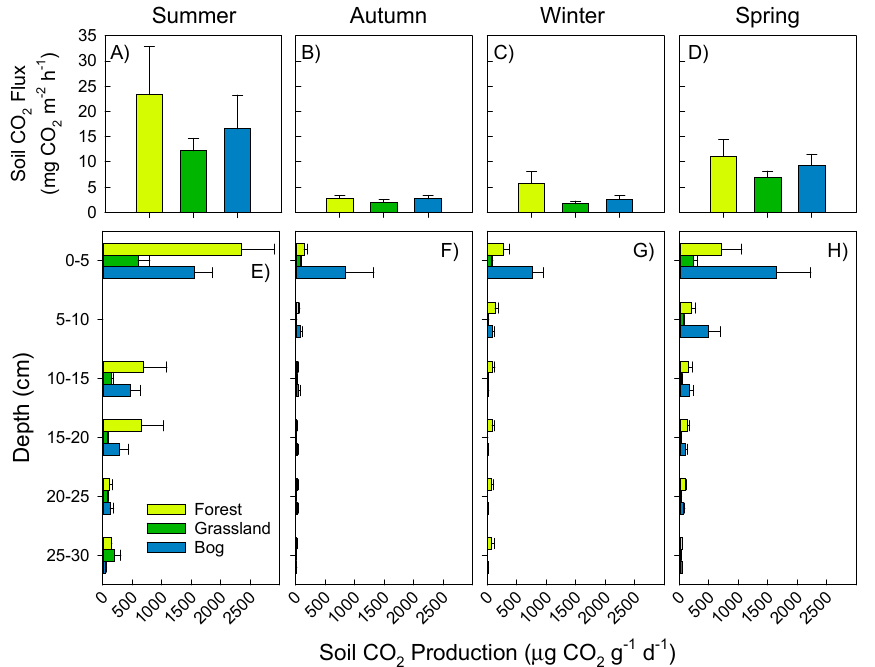
Figure 2. Soil CO 2 fluxes (top panels, A – D ) and production (bottom panels, E – H ). Surface flux measurements and soils collected for production on 17 February (summer, A , E ), 25 May (autumn, B , F ), 22 September (winter, C , G ), and 23 November (spring, D , H ) in 2015. Mean and standard error shown ( n = 4). In situ CH 4 fluxes ranged from − 413 to +778 µg CH 4 m − 2 h − 1 (Figure 3A–D). Absolute fluxes, either positive or negative, were greatest in summer compared to other seasons.